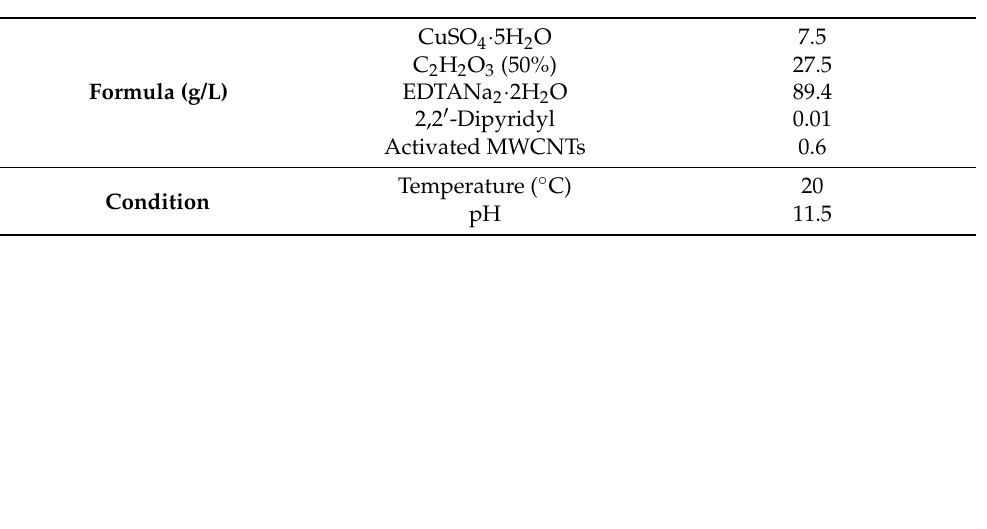
Table 2. Formula and conditions of electroless Cu